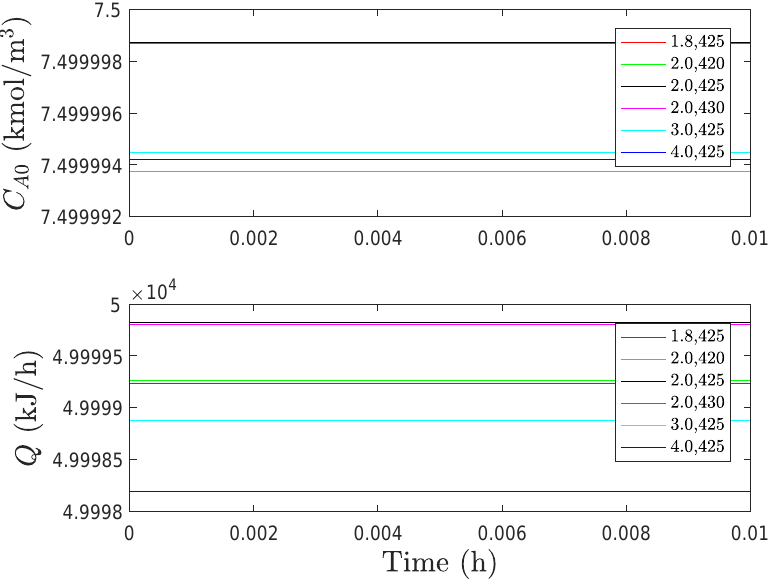
Figure 12. Values of C A 0 and Q for one sampling period for various cyberattack